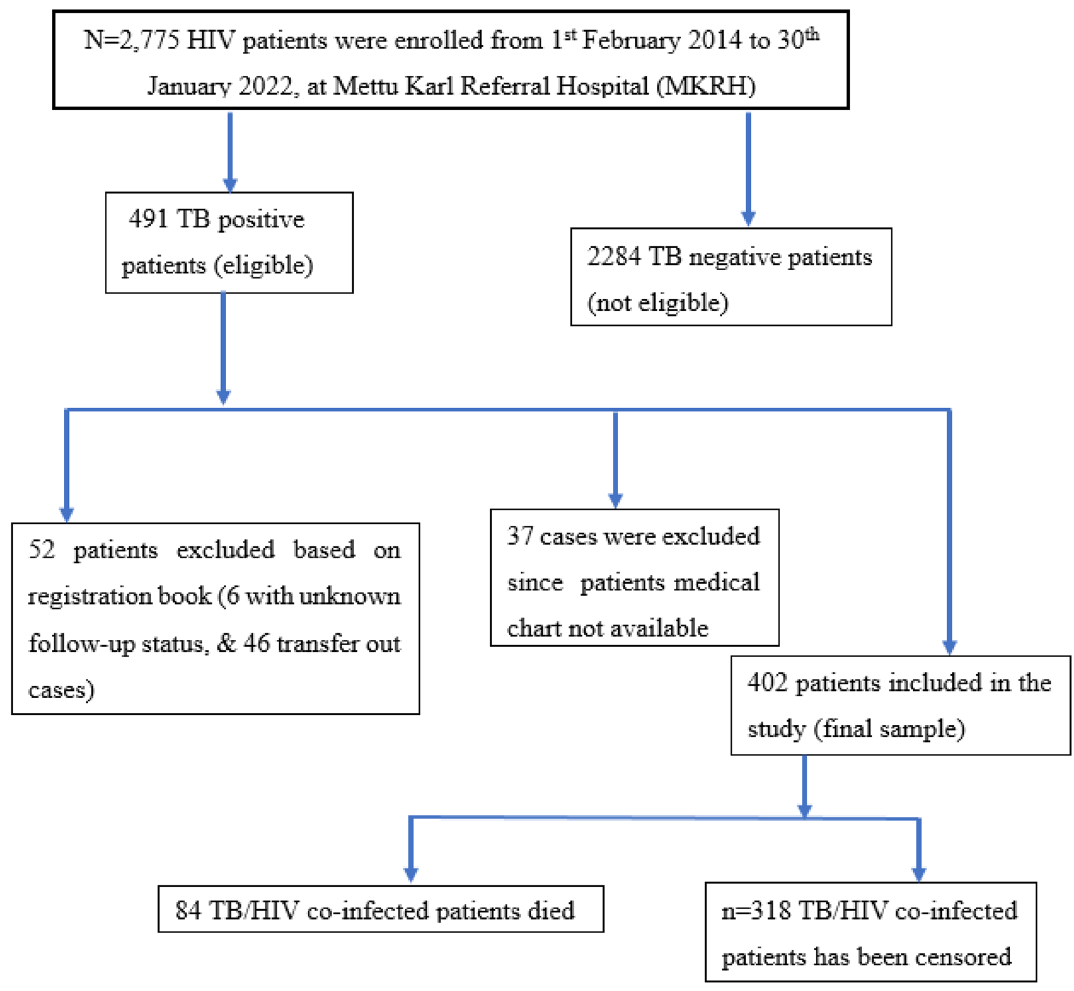
Figure 1. Overall enrollment of the adult patients co-infected with TB/HIV on ART at Mettu Karl Hospital, Ethiopia, 2014–2022 (n =